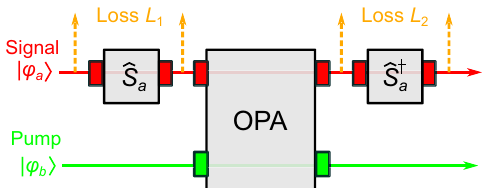
FIG. 5. The construction of an extended PNR QND measure- ment. The external squeezing operations modify the measured ˆ ˆ observable to ˆ N eff = S a . We model the loss of each squeezer S † a ˆ N a by a pair of equal beam splitters placed before and after the